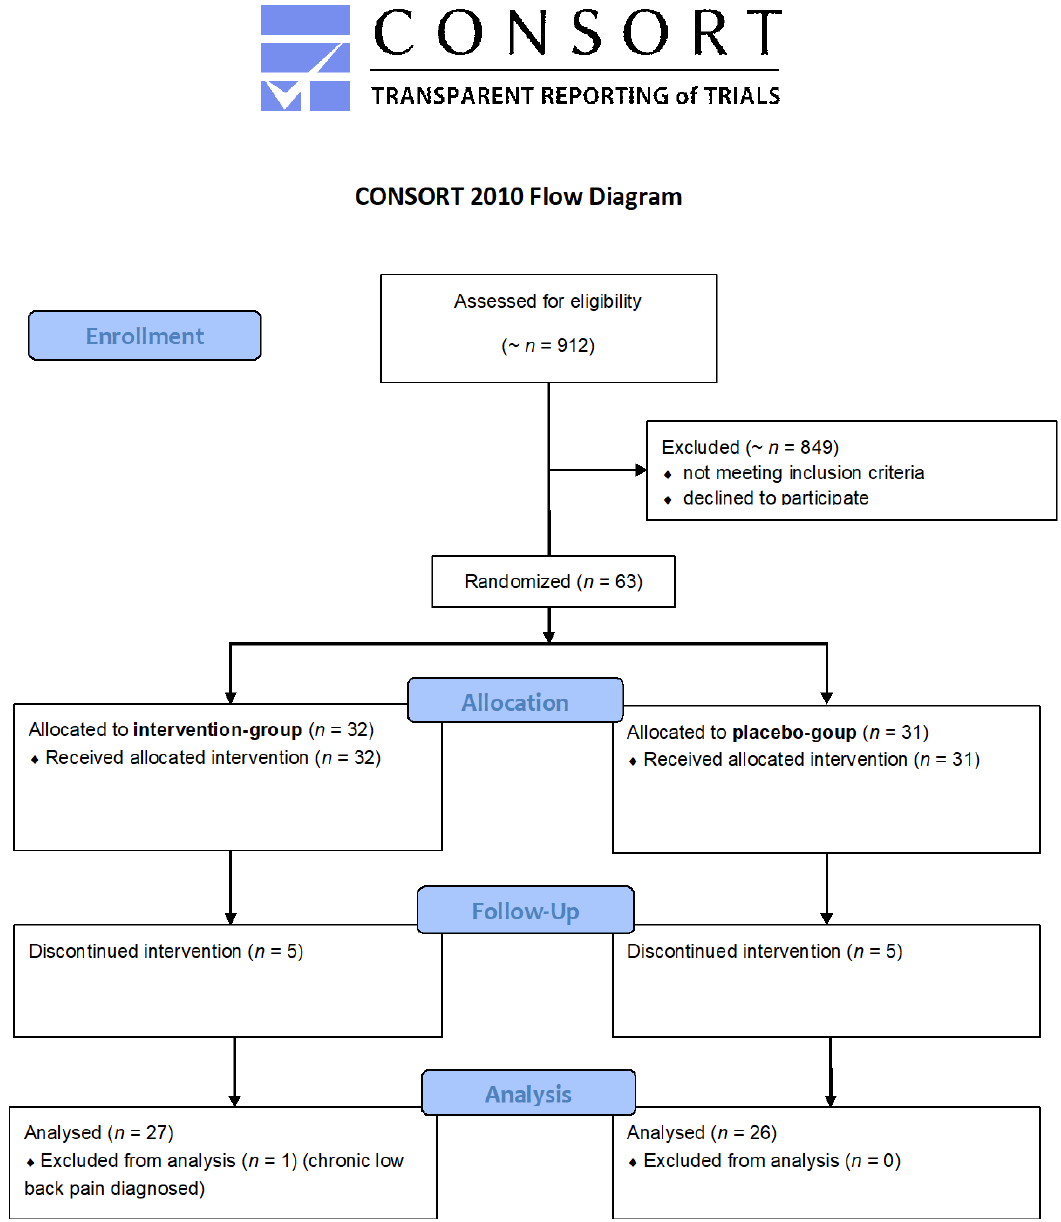
Figure 1. Consolidated standards of reporting trials (CONSORT) 2010 flow diagram for patient selection.